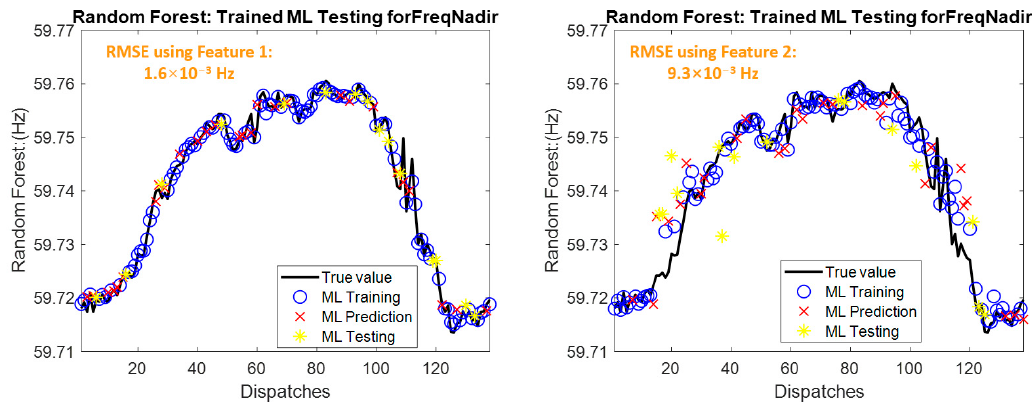
Figure 13. Impact of feature selection on the performance of the AI-agent.